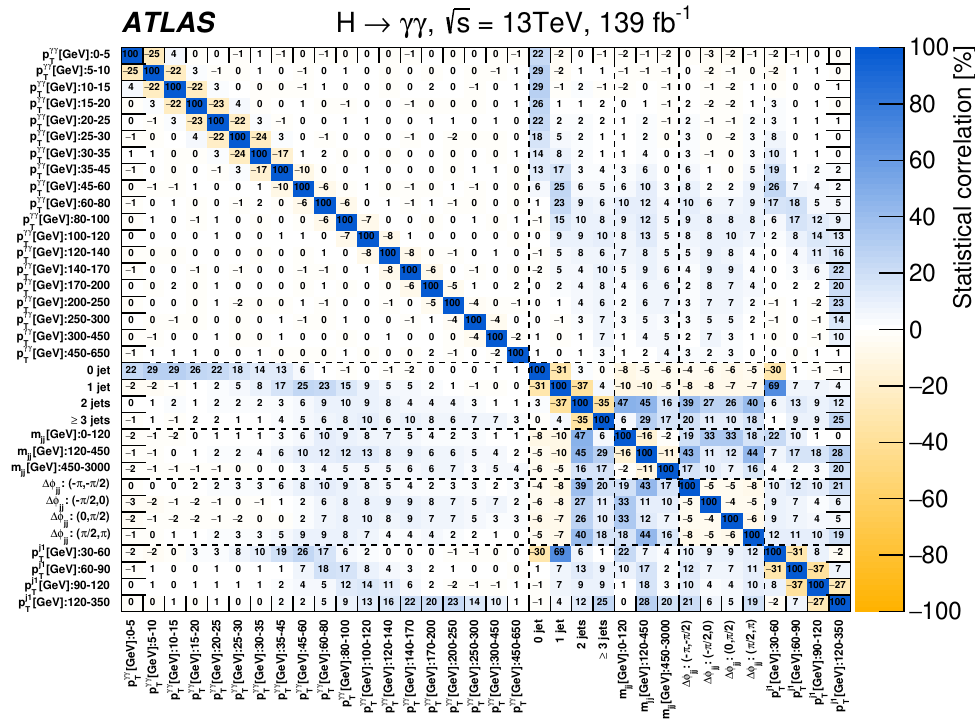
Figure 20. The observed statistical correlations, evaluated with a bootstrapping technique, between , N , m , ∆ φ and p j 1 are p γγ jets jj jj T T